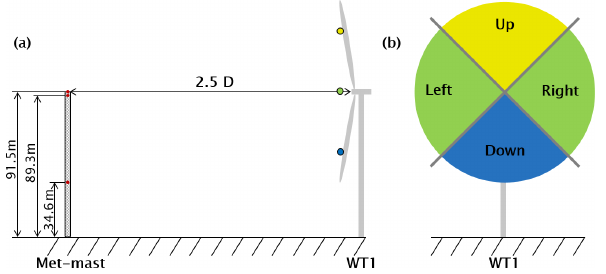
Figure 3. Definition of the four rotor sectors and their relative posi- tion with respect to the met mast (a) . View looking downstream (b)